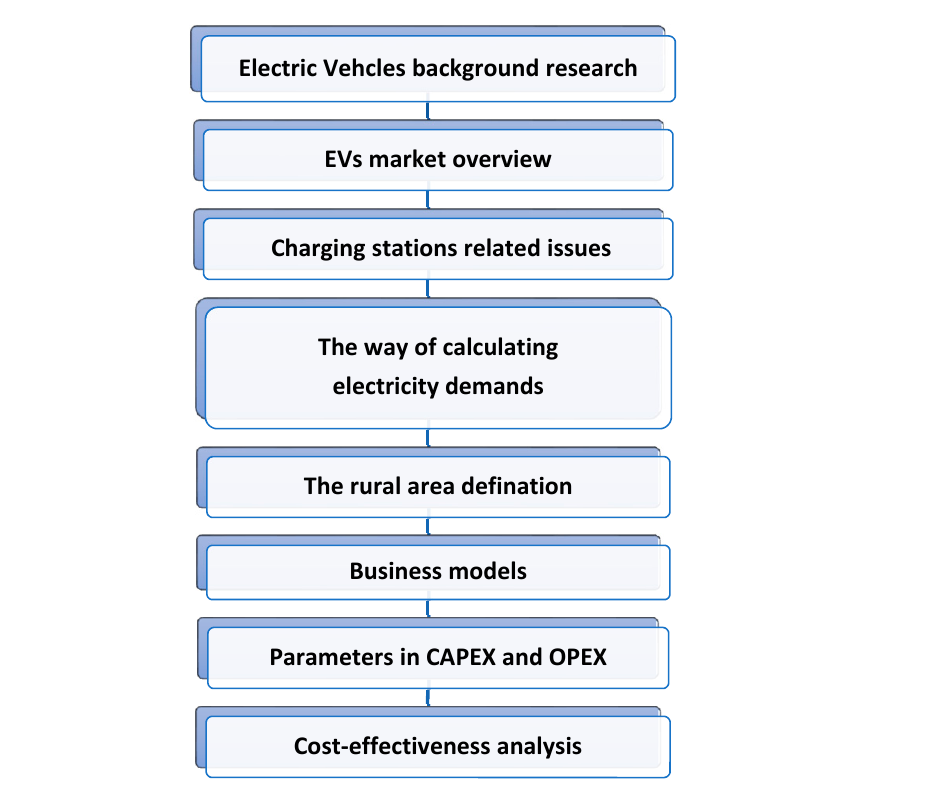
Figure 18. Content structure.